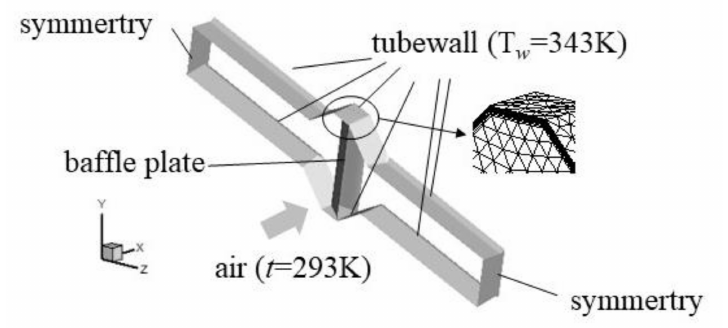
Figure 5. Schematic diagram of boundary conditions and enlarged view of the local